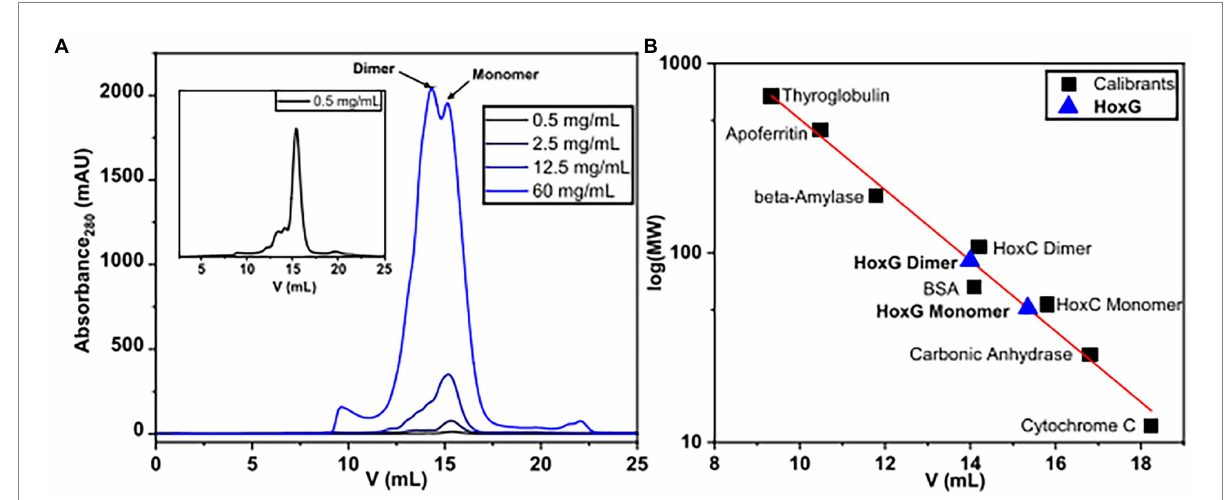
FIGURE 7 Size-exclusion chromatography measurements of HoxG in different protein concentrations (A) were performed in 50 mM K i PO4, 150 mM NaCl, pH = 7.4, T = 4 ° C. Monomeric and dimeric forms were calculated based on reference proteins (B)